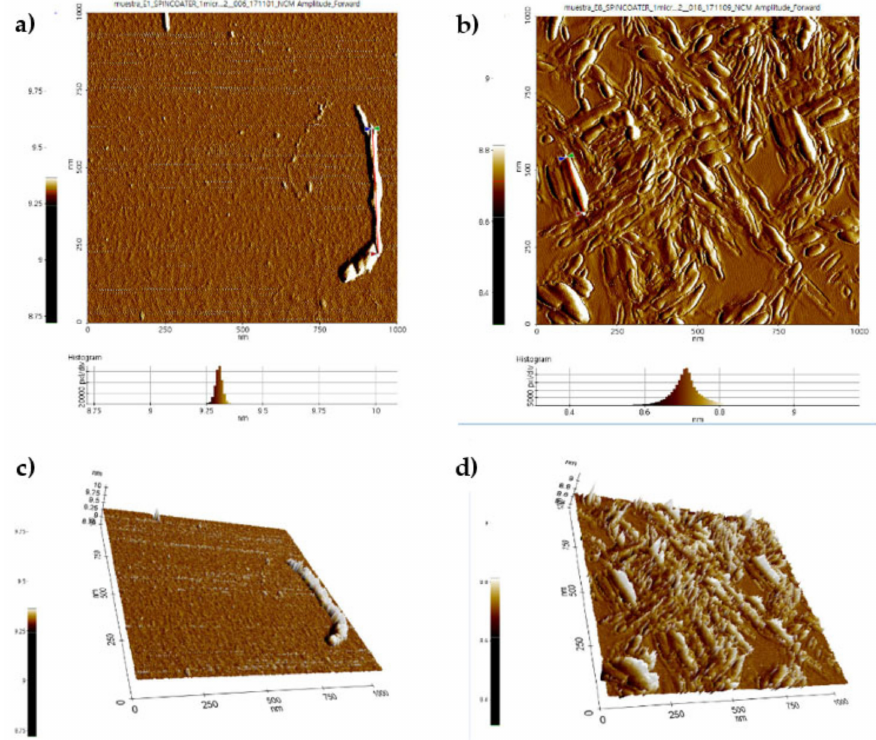
Figure 7. AFM images of CNC-S for two different conditions: ( a ) 2D image and histogram of E1S, ( b ) 2D image and histogram of E8S, ( c ) 3D image of E1S, ( d ) 3D image of E8S. For the rest of the CNC-S samples, the L diminishes as H 2 SO 4 concentration increases, with a minimum and maximum L value of 88 and 516 nm, respectively. Most of the samples exhibited W values between 20 and 84 nm, and H values of 9.0 and 9.3 nm. The complete set of AFM images of CNC-S are shown in Figure S4 and the AFM dimensions obtained from AFM images are presented in Table